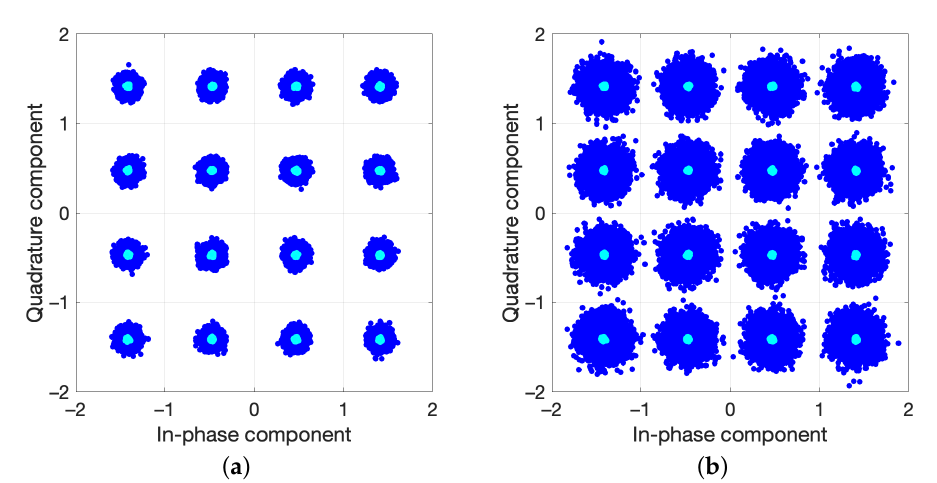
Figure 11. Constellations of the output signal, without (blue) and with DPD (cyan). ( a ) Average output level: 30 dBm, corresponding to an input level of − 21 dBm at the VSG (EVM = 4.6% without DPD, and 0.6% with DPD). ( b ) Average output level: 30.7 dBm, corresponding to an average input level of − 17 dBm at the VSG (EVM = 10.3% without DPD, and 0.6% with DPD).